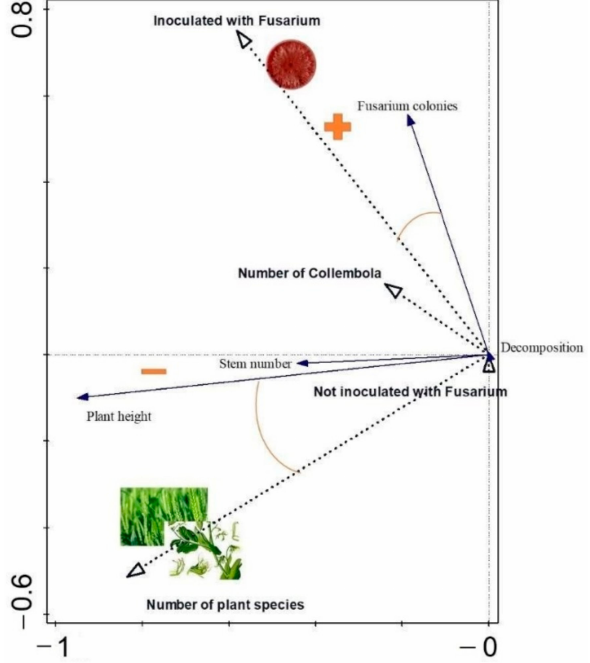
Figure 6. RDA biplot representing the dependent variables correlated with the experimental